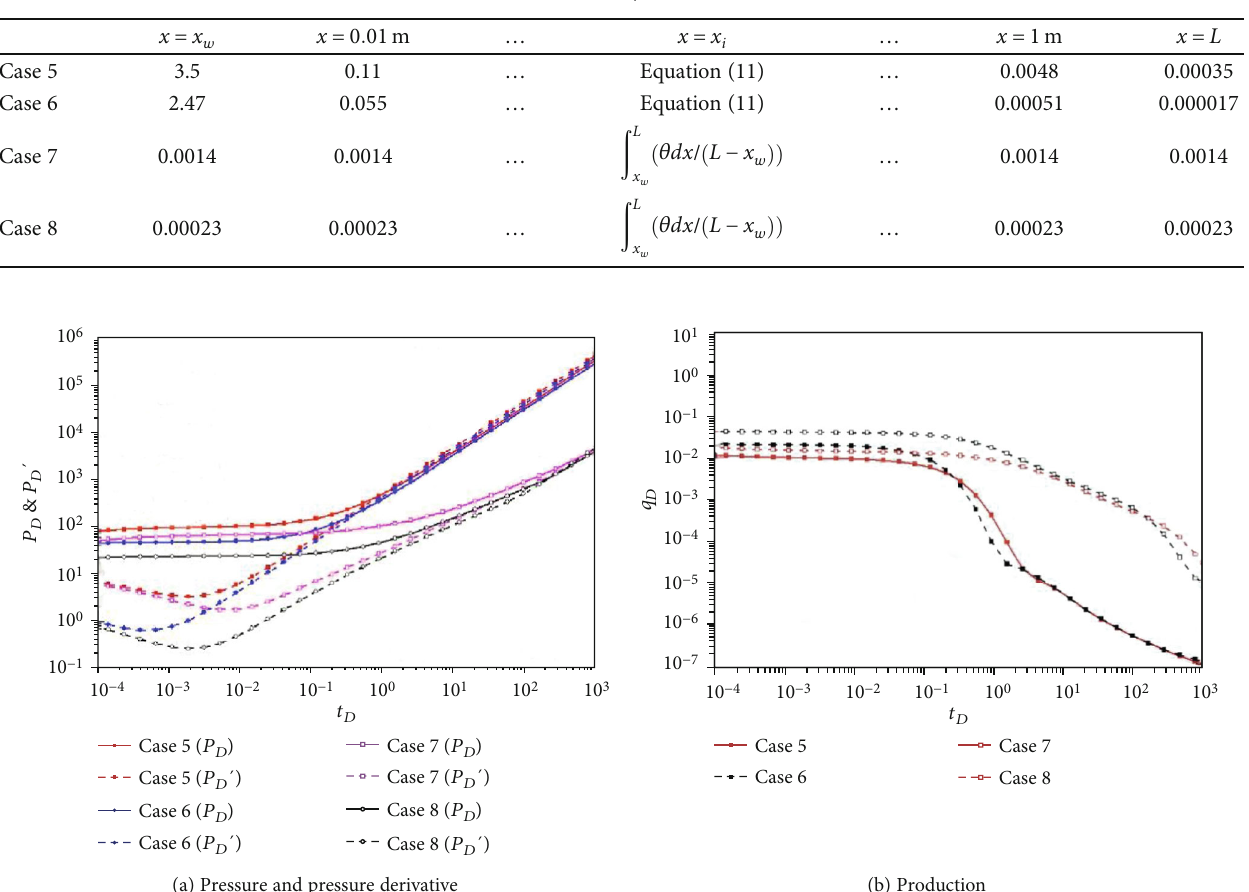
Figure 3: In fl uence of secondary fracture spacing on pressure and production. Table 3: The distribution of tortuosity fractal index with di ff erent cases.